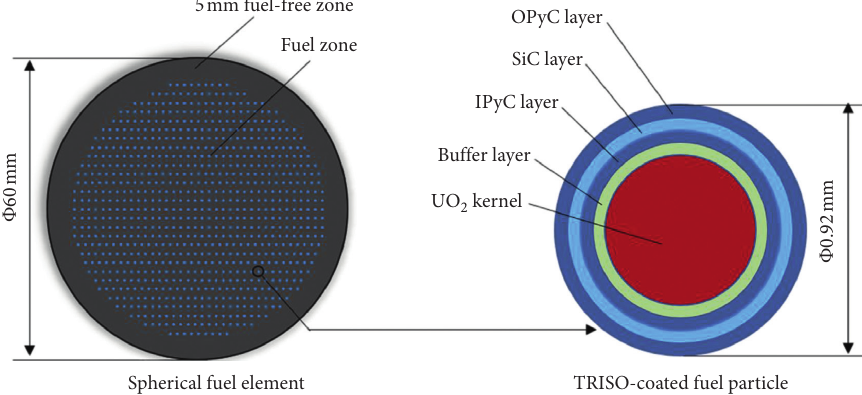
Figure 1: The profiles of spherical fuel element and TRISO-coated fuel